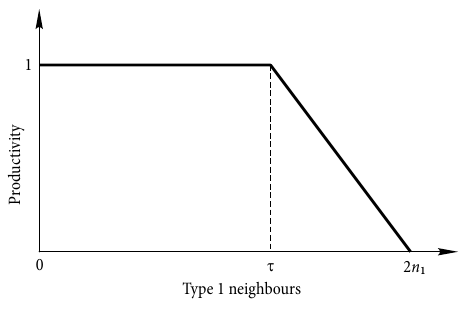
Fig. 3. Productivity function of disadvantaged